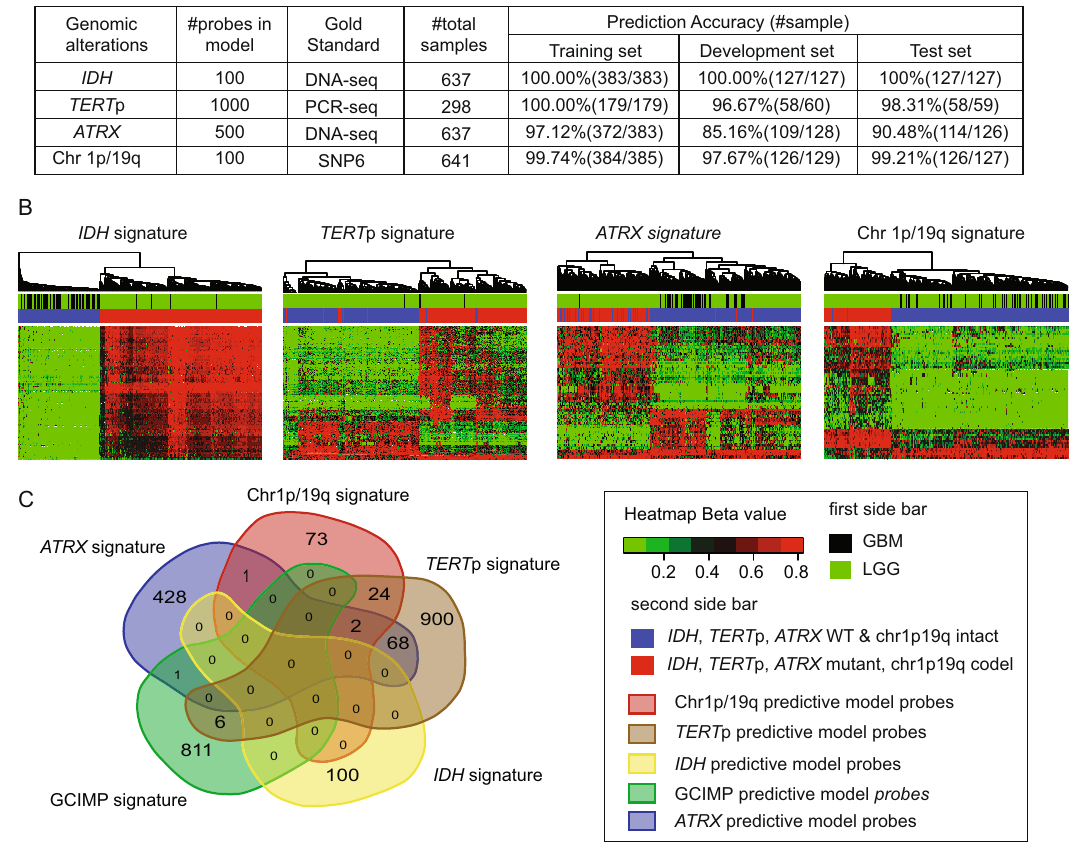
Fig. 1 Methyl-based predictive models ’ performance and signatures analysis. A Summary of DNA methylation-based model performance for each binary genetic alteration and number of probes involved in each predictive signature. B Heatmaps of DNA methylation level ( β value): samples are in columns and DNA methylation probes are in rows. The two top sidebars show the sample source and genetic alteration status. From left to right, each image shows the most signi fi cant probes in signatures of IDH (number of probes = 100), TERT p (number of probes = 200), ATRX (number of probes = 90), and chr1p19q codel (number of probes = 70). C In this Venn diagram, the predictive model probes of each binary genetic alteration (number of probes: IDH = 100, TERT p = 1000, ATRX = 500, chr1p19q codel = 100) and the G-CIMP probes (number of probes = 818) identi fi ed in the published paper 33 were compared with each other. Different colors represent different probe sets. The overlapping blocks between any probe sets indicate the overlapping probes. The number within the diagram indicates the number of probes within a speci fi c